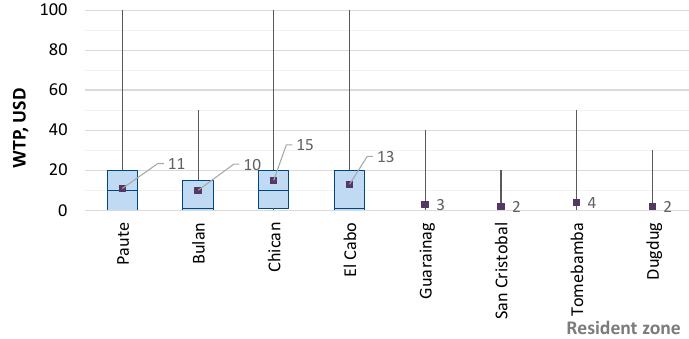
Figure 11. Box-plots for the correlation between WTP and the resident zone of the respondents (the bullet represents the average value for each category).